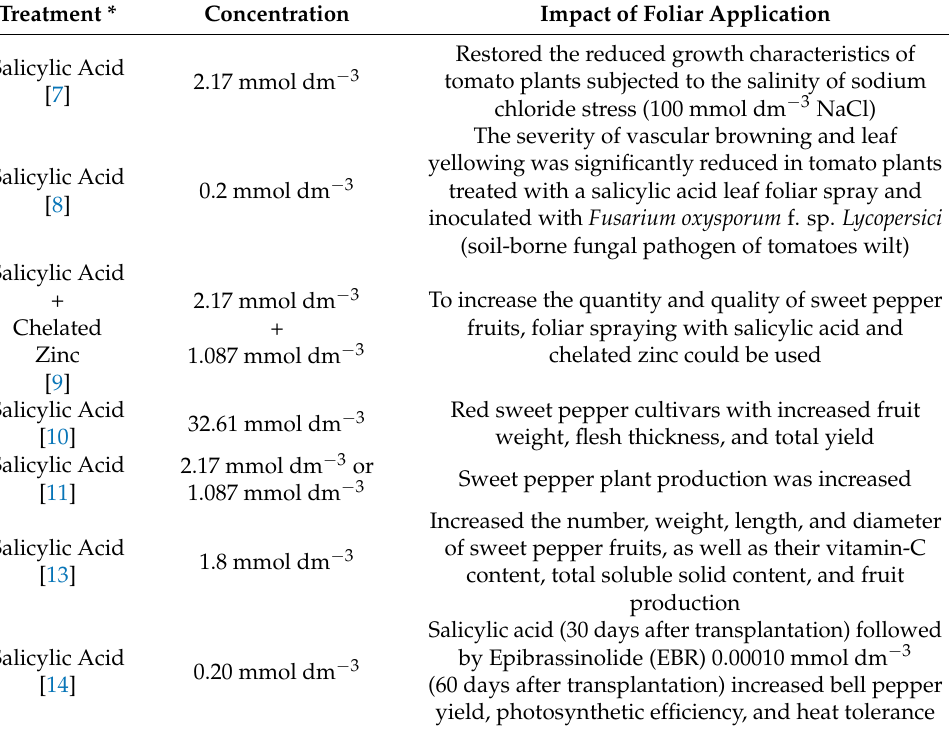
Table 1. The most important studies in salicylic acid foliar spraying in tomatoes and